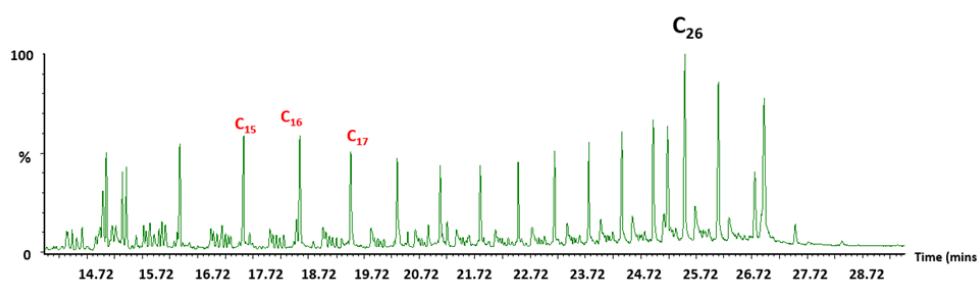
Figure A5. Thermal desorption chromatogram for R2.